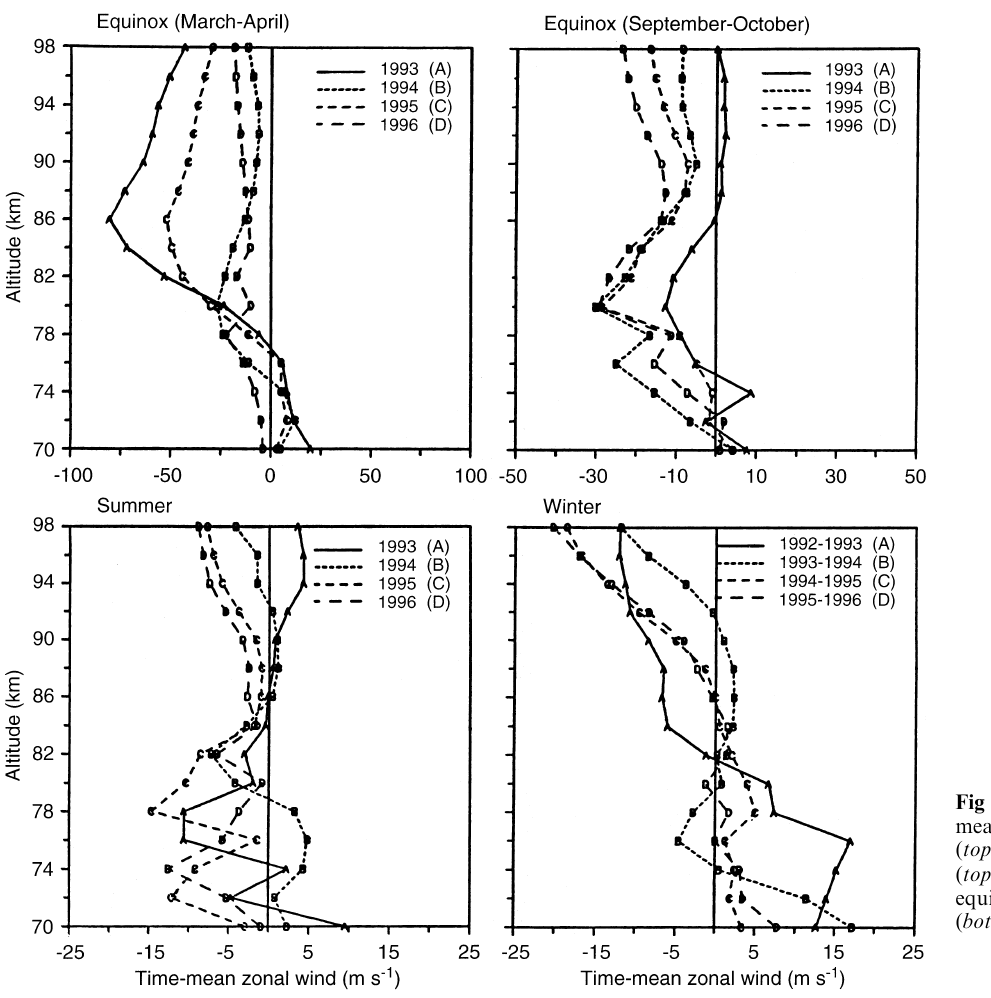
Fig 2. Altitude profiles of time- mean zonal wind over Tirunelveli; ( top left ) March–April equinox; ( top right ) September–October equinox; ( bottom left ) summer; ( bottom right